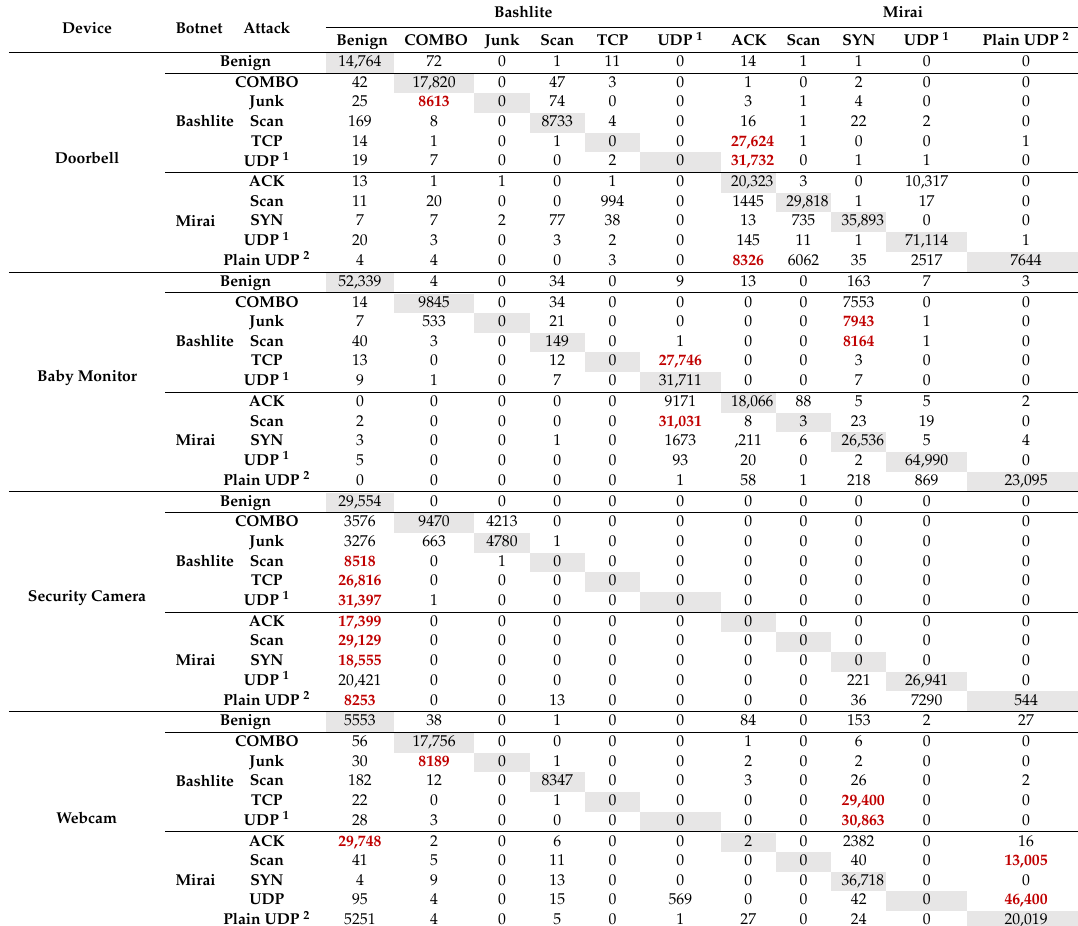
Table 16. F1-score of each specific attack for